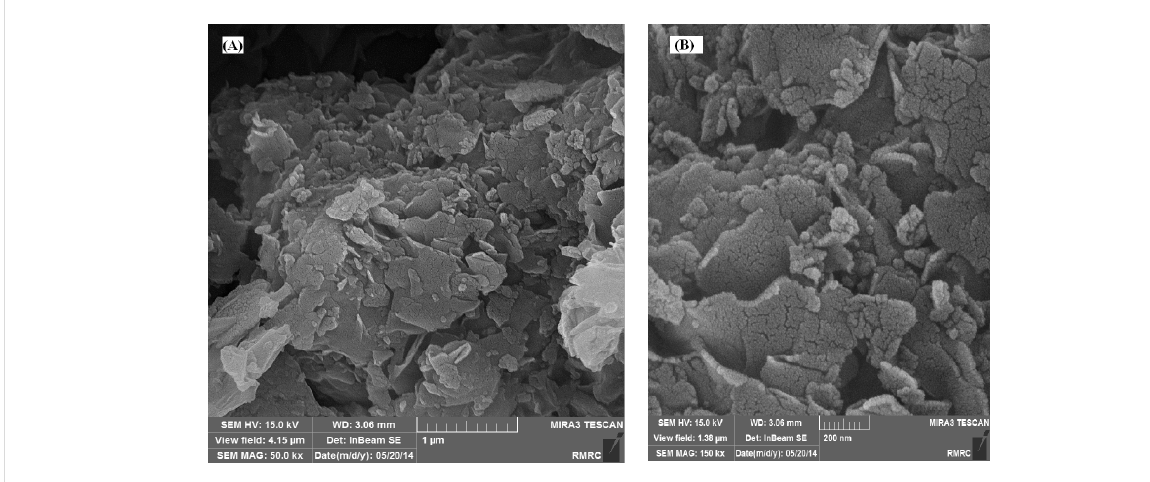
Figure 4: Typical FE-SEM images of Cu NPs/bentonite. Scale bar: (a) 1 µm and (b) 200 nm.